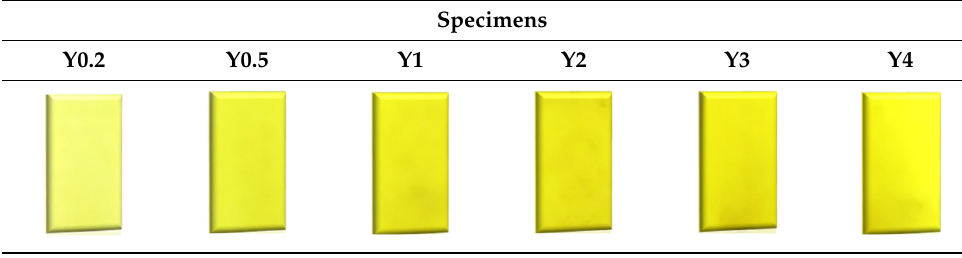
Table 5. Color parameters of Specimens dyed with dye Disperse yellow 3 (DY3).